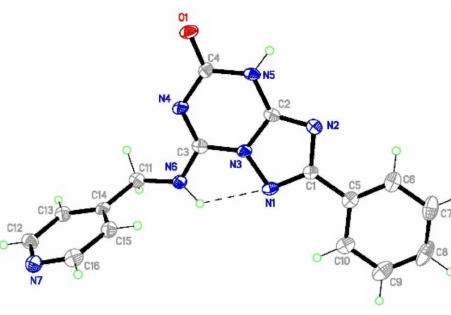
Scheme 7. Synthesis of 5-aza-isoguanines 6 .